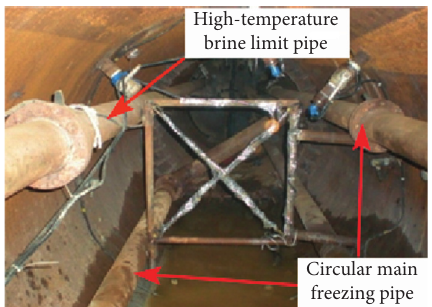
Figure 6: Arrangement of freezing pipes and limiting pipes in the steel pipe of the pipe